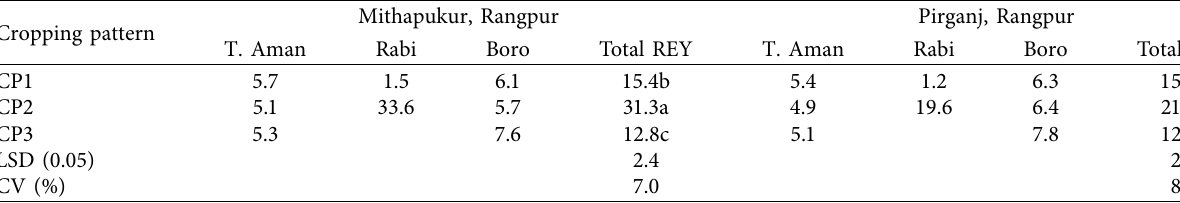
Table 4: Total rice equivalent yield (REY) of different cropping patterns (CP1: T. Aman-Mustard-Boro, CP2: T. Aman-Potato-Boro, CP3: T. Aman-Fallow-Boro) in Rangpur during 2019–2020. Cropping pattern